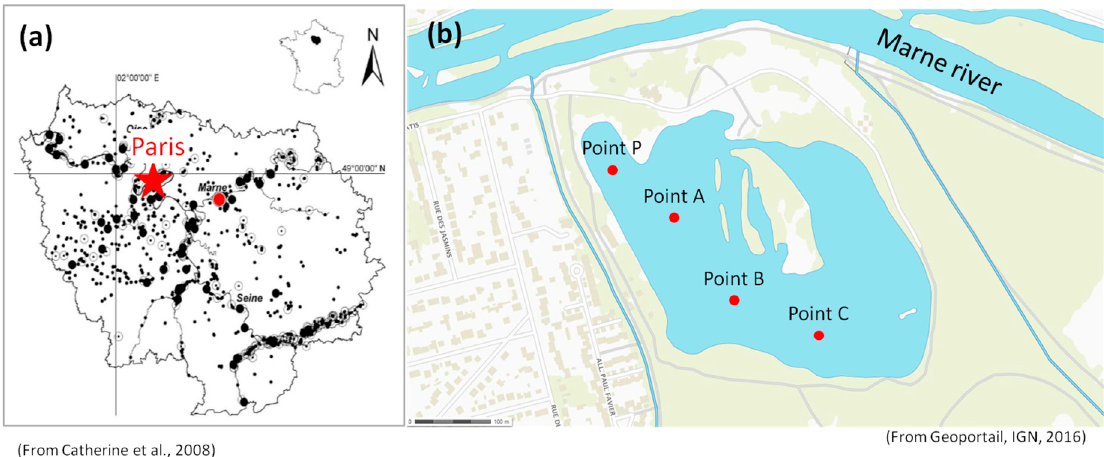
Figure 1. Localization of ( a ) Lake Champs-sur-Marne and ( b ) the different monitoring points.